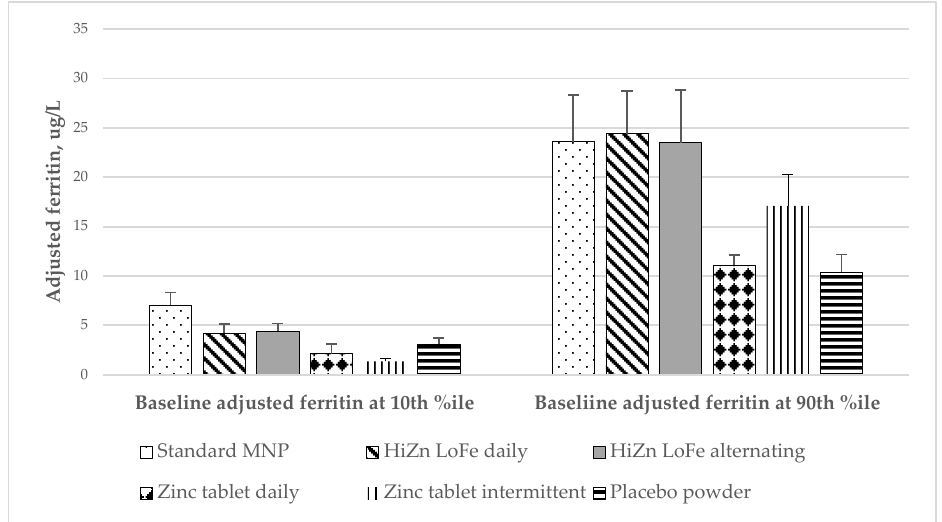
Figure 2. Adjusted ferritin concentrations at 24 weeks shown by adjusted ferritin concentration at baseline